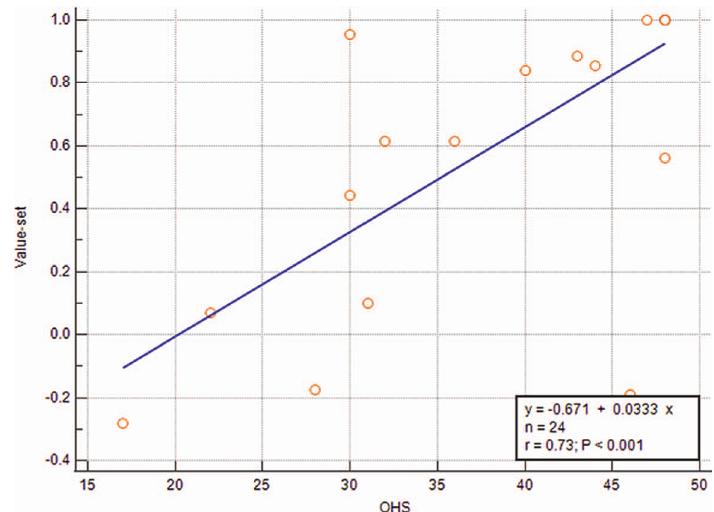
Figure 2. Correlation between Oxford hip score (OHS) and the value set of the EQ5D5L in 24 patients with ipsilateral femur and acetabular fracture.